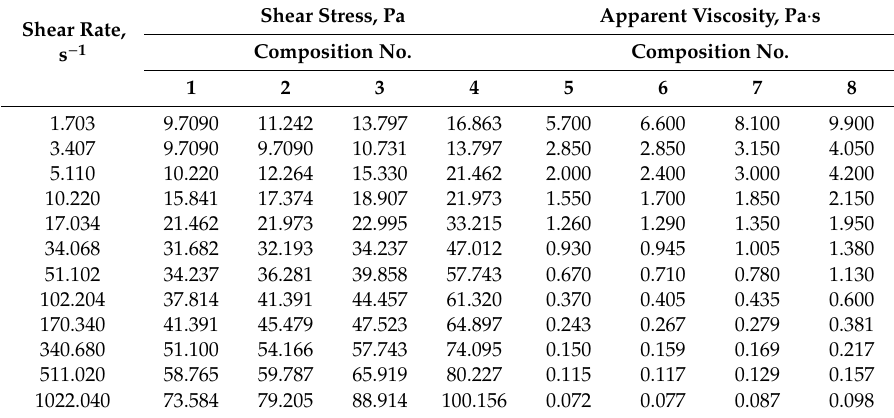
Table 4. Results of measurements and calculated values of apparent viscosity for slurries with graphene oxide without a latex admixture.